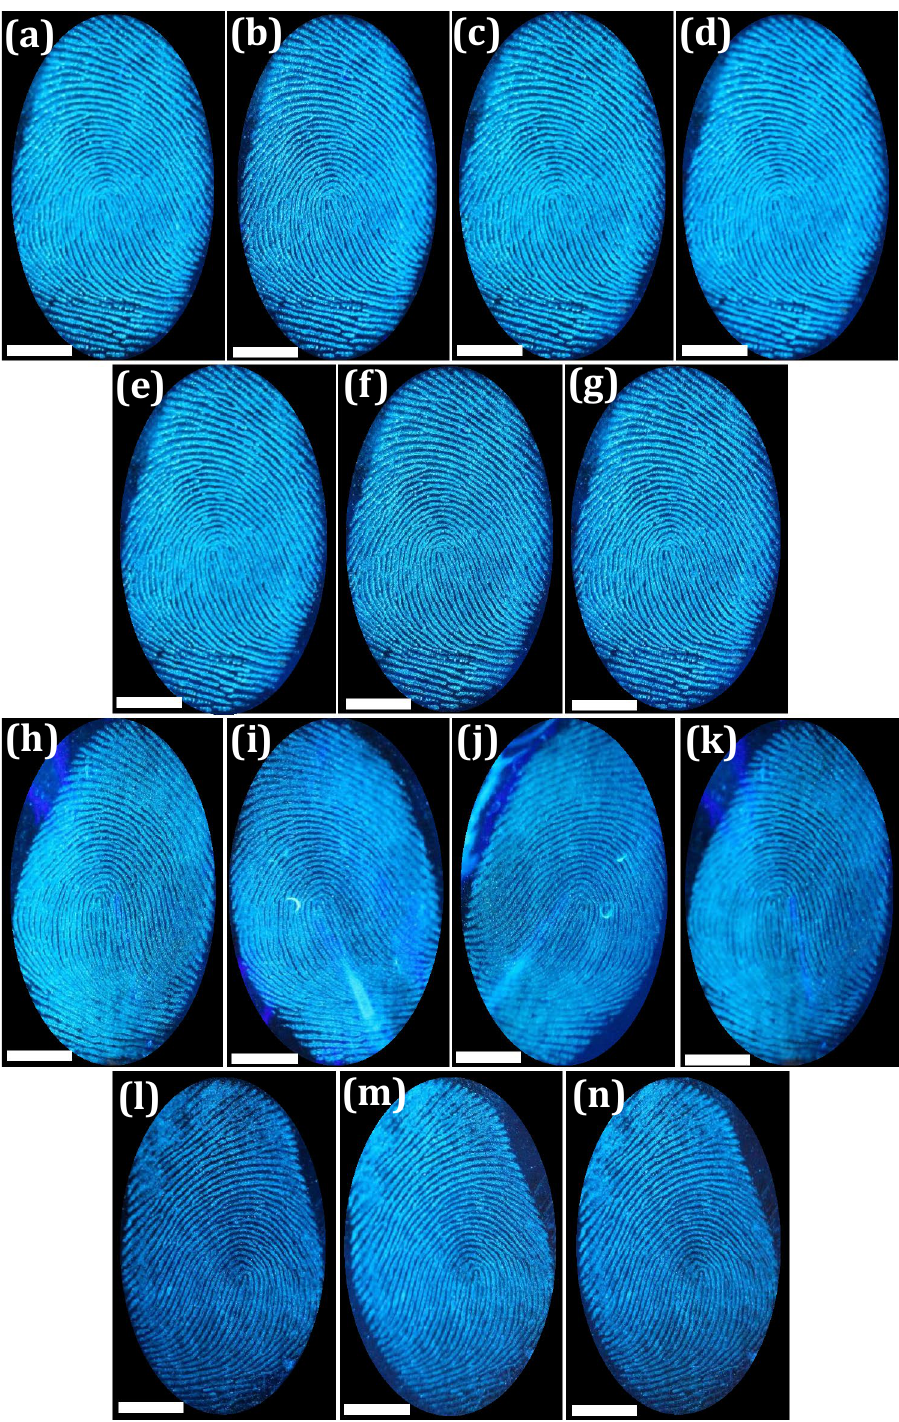
Figure 5. Stability assessment of FP images developed using FDIP solution on the glass surface; ( a–g ) developed FPs was examined upon high intensity UV 365 nm illumination (2 mW/cm 2 ) 0 to 6 h; ( h–k ) FPs maintained at different temperatures (30, 50, 100 and 150 °C) for 30 min; ( l–n ) FPs developed under various weather as well as time durations (May, temperature ~ 45 °C, humidity 47%; September, temperature ~ 30 °C, humidity 81%; January, temperature ~ 15 °C, humidity 40%) The corresponding grayscale images were shown in Fig. S6 (Scale bar: 5